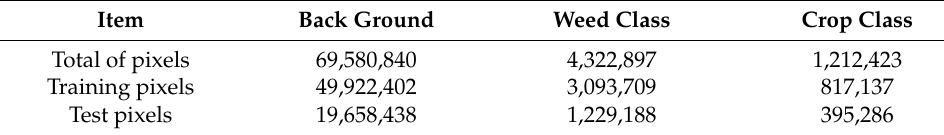
Table 3. CWFID dataset pixels